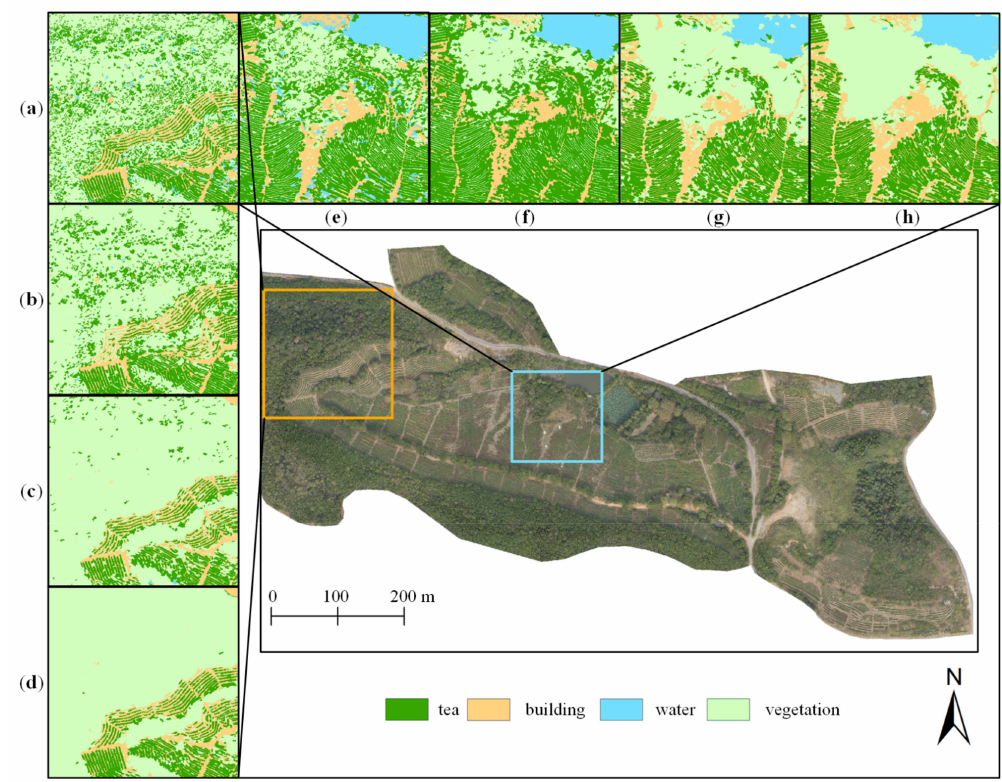
Figure 13. Comparison of the recognition effects obtained using the four models in the northwest (( a – d ) Models 1–4) and middle (( e – h ) Models 1–4) regions of the study area.